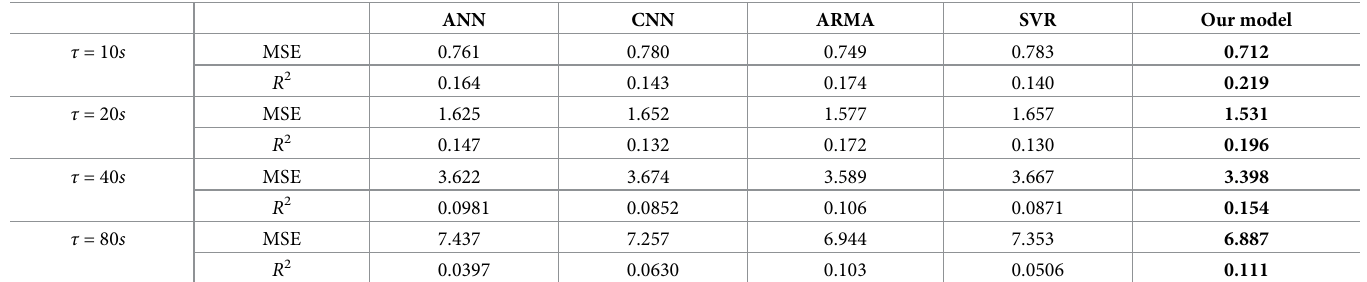
Table 2. The experiment result in OKCoin dataset.